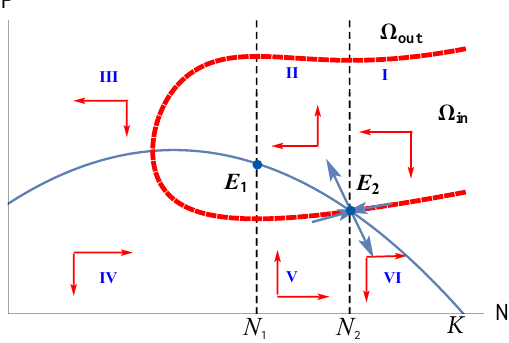
Fig. 5. Nullclines for the model (4) in the case of one stable internal equilibrium and an internal saddle point; the thick dashed line separates the positive cone into two disjoint sets— Ω in and Ω out